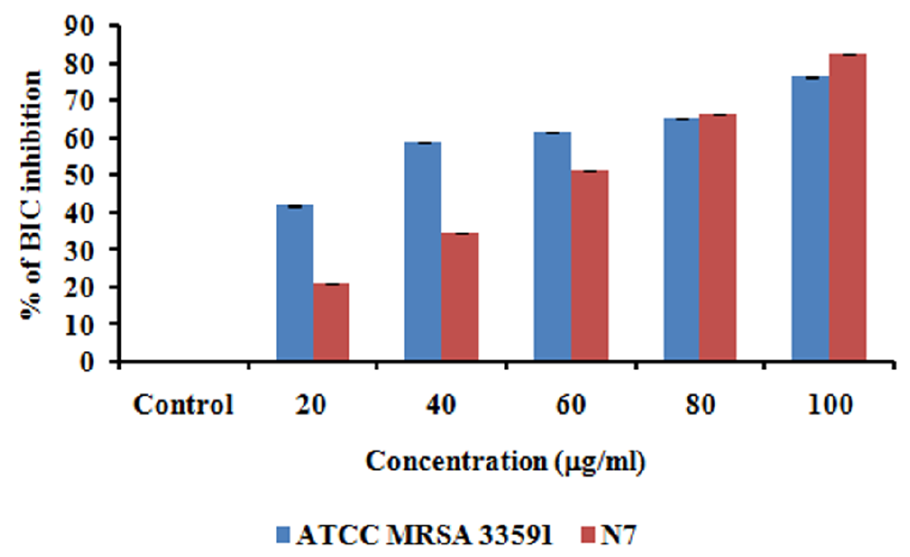
Figure 9. Quantification of biofilm inhibition potential of MG@Folate ZIF-L by crystal violet assay.